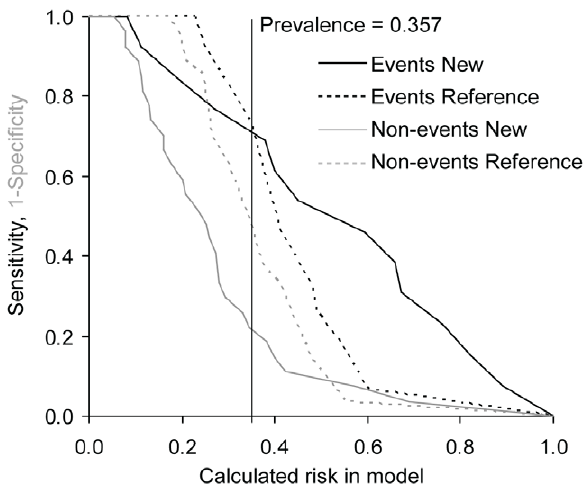
Figure 1. Risk assessment plot of the performance comparison between reference EuroSCORE model and new EuroSCOR- E + MDA model for combined safety endpoint at 30 days in TAVI + SAVR group (N=42). Prevalence – occurrence of endpoint in given group.